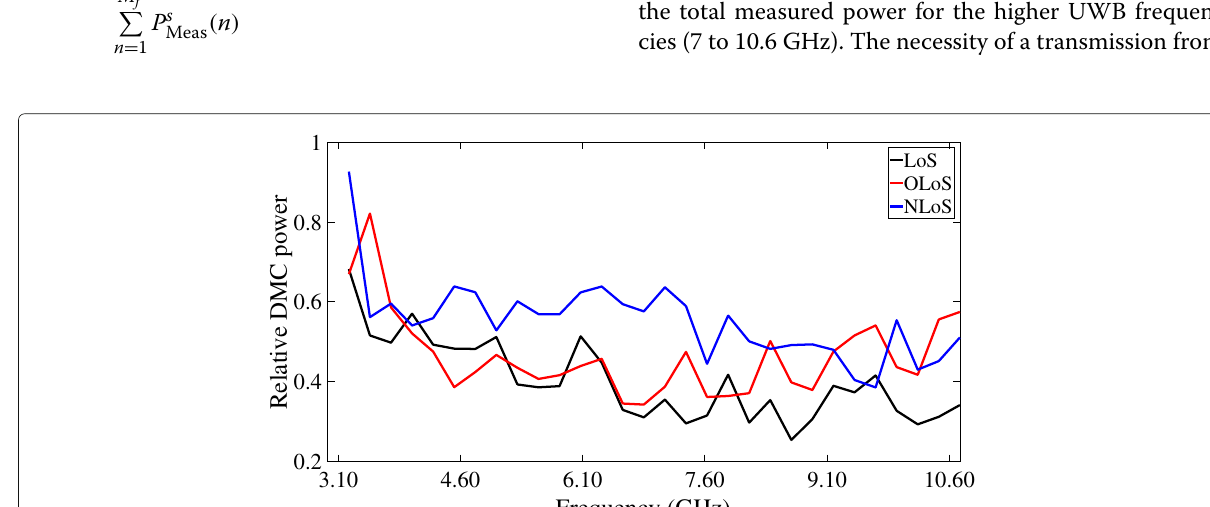
Fig. 19 Relative DMC power ratio p r as a function of UWB frequencies for LoS, OLoS, and NLoS